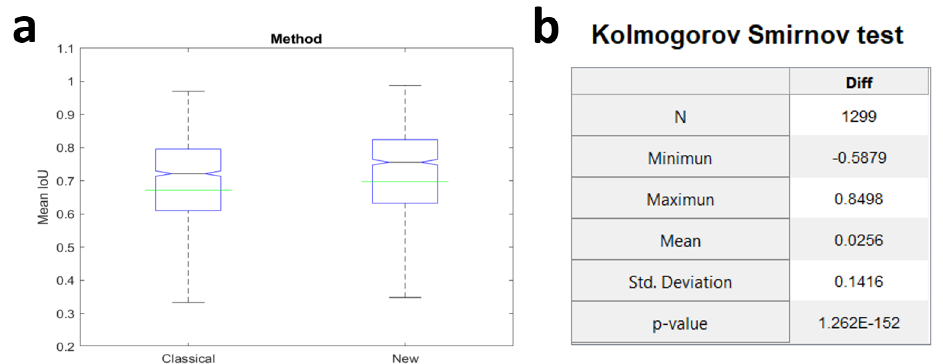
Figure A5. Box plot and normality test of the difference of both methods. ( a ) Box plot, green line indicates the mean in both graphs, and gray line indicates the median. Classical method, N = 1299, mean = 0.6719, median = 0.7218, std. deviation = 0.1842, variance = 0.0339. New method, N = 1299, mean = 0.6975, median = 0.7562, std. deviation = 0.1929, variance = 0.0372. ( b ) Normality test on the difference of methods (New-classical). The p -value obtained was 1.26E-152 less than the significance value of 0.05, so the null hypothesis was rejected and the alternative hypothesis H1 was accepted (data did not come from normal distribution). Once the alternative hypothesis was accepted, Wilcoxon signed ranks test was used to evaluate both methods.